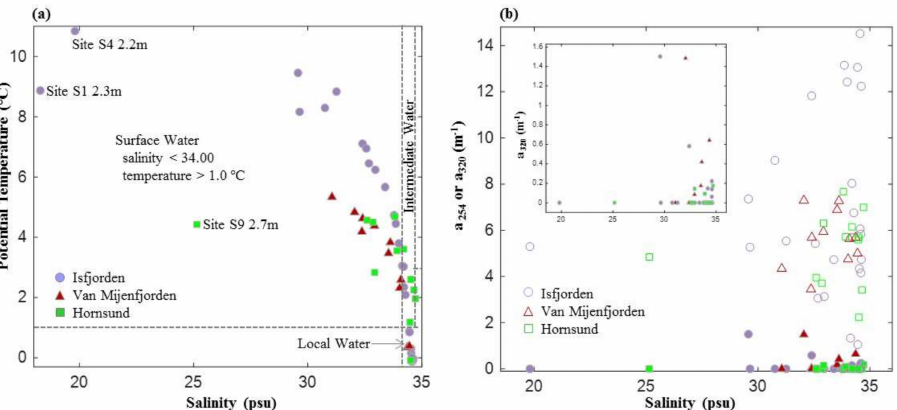
Figure 3. The property-property plot of θ -S of all the seawater samples ( a ) and the distribution of a 254 (open symbols) and a 320 (filled symbols) as a function of the salinity ( b ). The dotted frames in ( a ) classify water masses. An inlet for the salinity-a 320 plot is shown in ( b